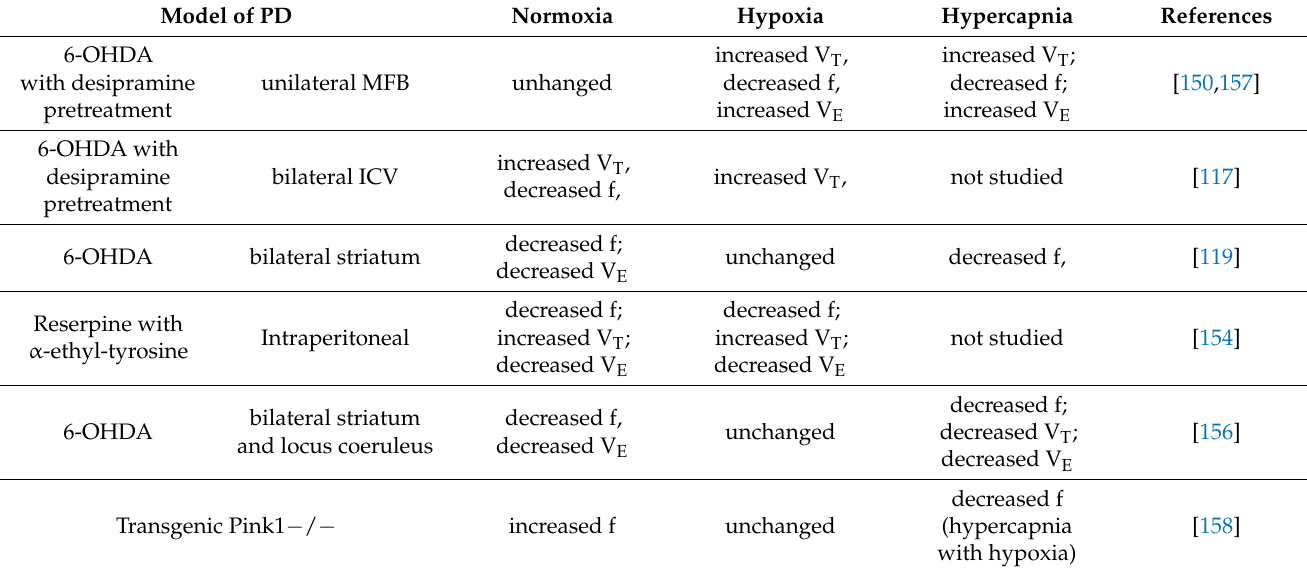
Table 2. Ventilatory responses to hypoxia and hypercapnia in experimental rat models of PD. V T ; tidal volume, V E ; minute ventilation, f; respiratory